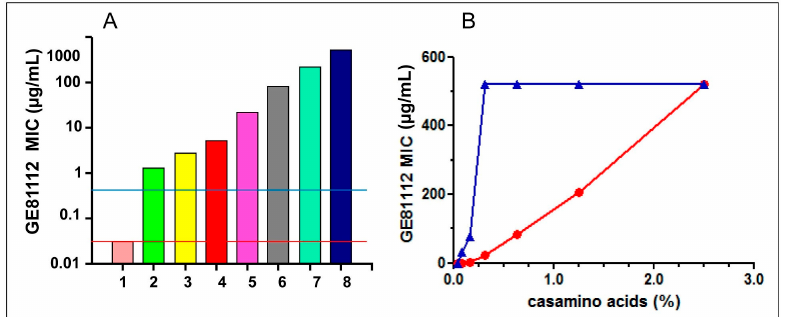
Figure 3. Effect of various additions to Minimal media on the antibacterial activity of GE81112: ( A ) The MIC of GE81112 was tested on E. coli MG1655 growing in David Mingioli minimal medium supplemented with the following % concentrations of casamino acids: from 1 through 8 = 0; 0.04; 0.08; 0.16; 0.31; 0.63; 1.25; and 2.50. The horizontal lines indicate the MIC measured in the presence of 0.1 mg/mL of individual amino acids (red line) and 1.25% pooled purified amino acids (blue line). The microtiter wells were filled with 100 μ L medium inoculated with 10 4 cfu/mL and the MICs (expressed as μ g/mL) determined after 24 h growth at 37 °C. ( B ) Effect of increasing casamino acids concentrations (indicated in the abscissa) on the MIC of GE81112 on E. coli MG1655 (red circles) and Bacillus subtilis ATCC6633 (blue triangles). The experimental conditions are the same as indicated in panel A.